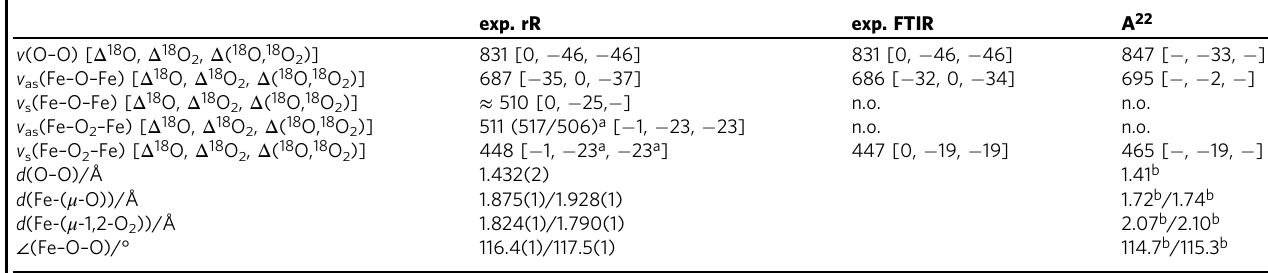
Table 2 Vibrational (resonance Raman and FTIR) frequencies (cm − 1 ) and isotopic shifts together with some metrical parameters for [(susan 6-Me ){Fe III ( μ -O)( μ -1,2-O 2 )Fe III }] 2 + and comparisons to those for